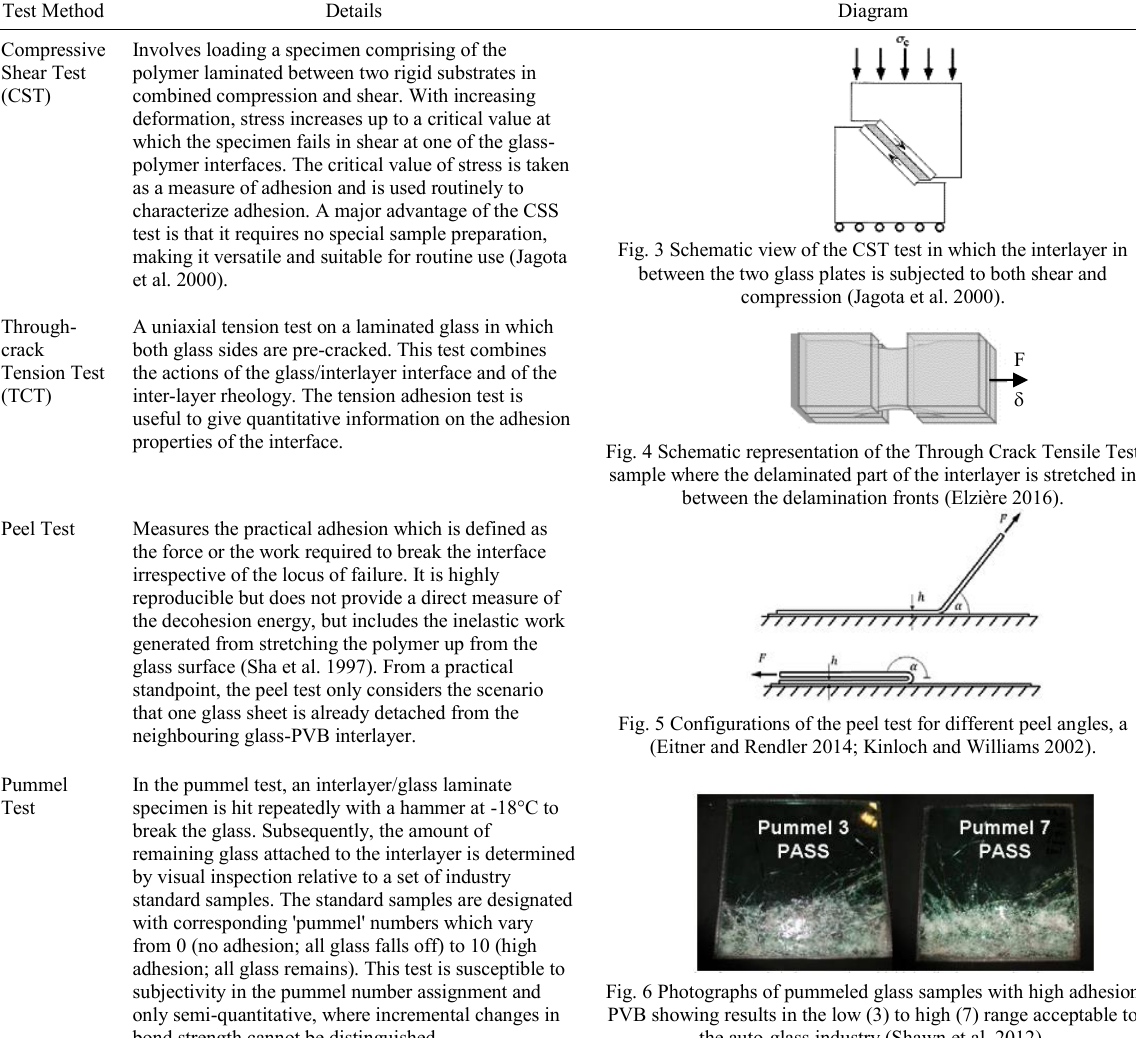
Table 2: Existing methods for measuring interfacial adhesion.